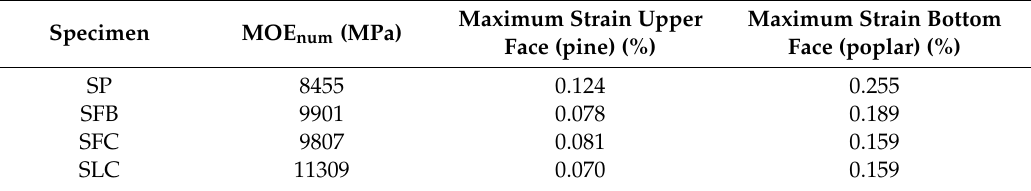
Table 4. Mechanical properties of each specimen numerically obtained.